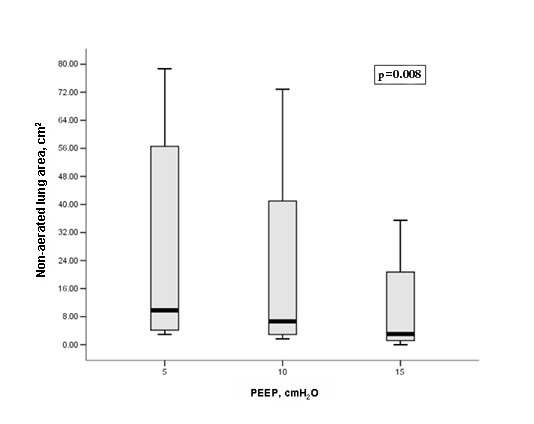
Boxplot of the nonaerated lung areas at different positive end-expiratory pressure (PEEP) levels (5, 10 and 15 cm H2O) in ARDS patients. {the upper and the lower boundary of the "box" (grey-shaded area) represents the 75th and 25th percentile of the data, the central black line of the " box" is the median value and the vertical lines indicate the maximum and the minimum values}